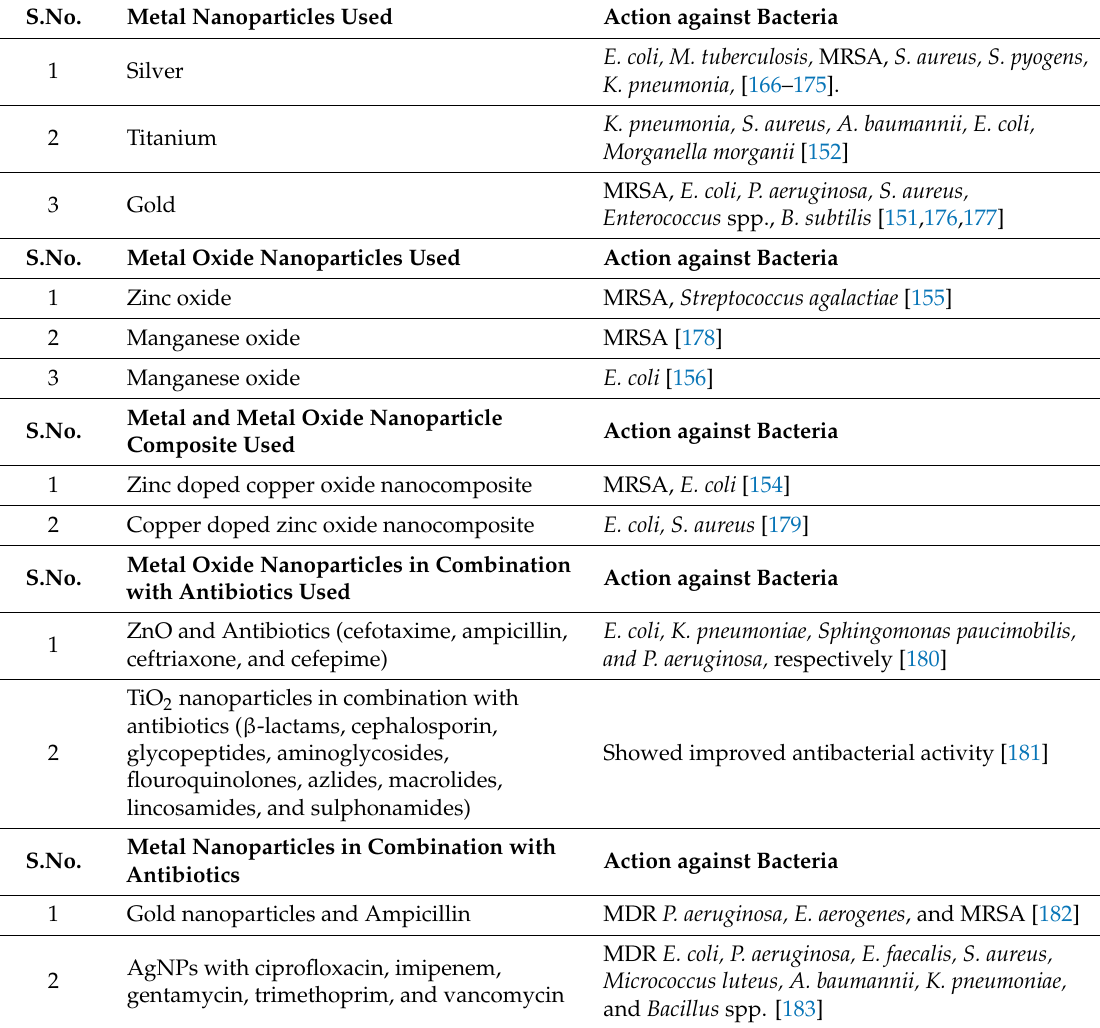
Table 5. E ff ect of metal / metal oxide nanoparticles with or without antibiotics against various bacteria.